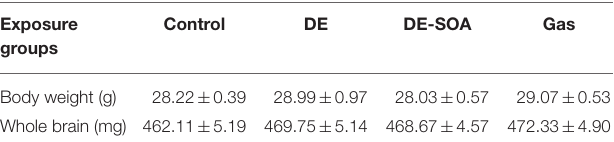
TABLE 2 | Body and brain weight of adult mice exposed to clean air, DE, DE-SOA, and gas during developmental period.